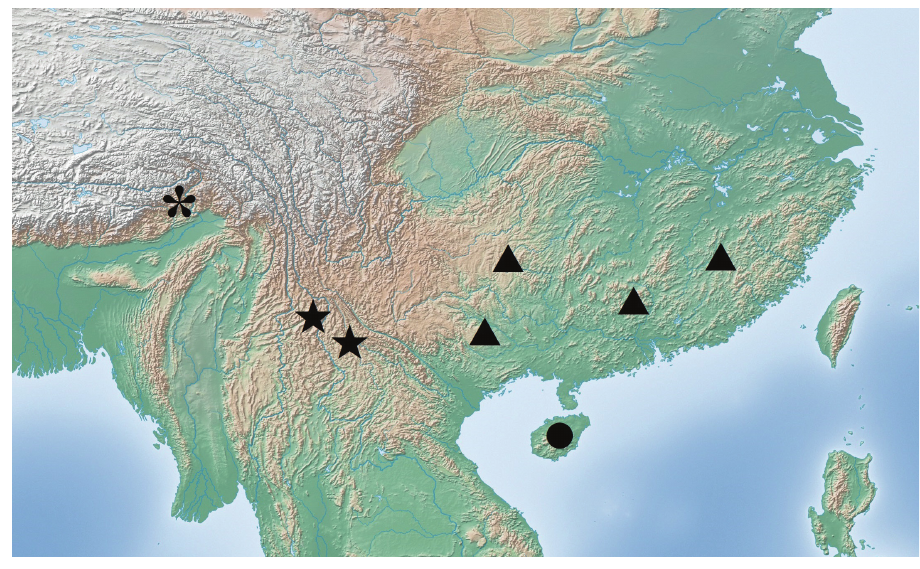
Figure 12. Distribution map of the distribution Theopropus spp. in South China. ▲ : T. sinecus sinecus ;